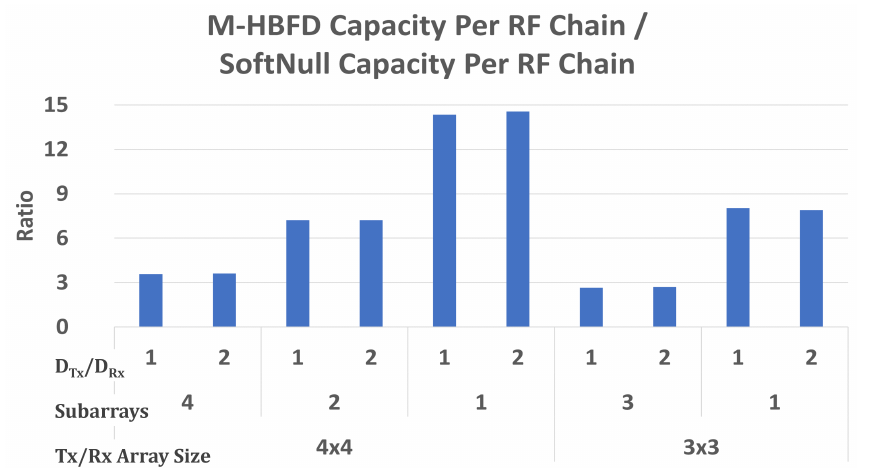
Figure 9. Effect of array size ((bottom), denoted by Tx/Rx Array Size row), number of subarrays ((middle), denoted by Subarrays row), and number of effective antennas per row ((top), denoted by D Tx /D Rx row) on capacity compared to SoftNull, normalized by number of RF chains